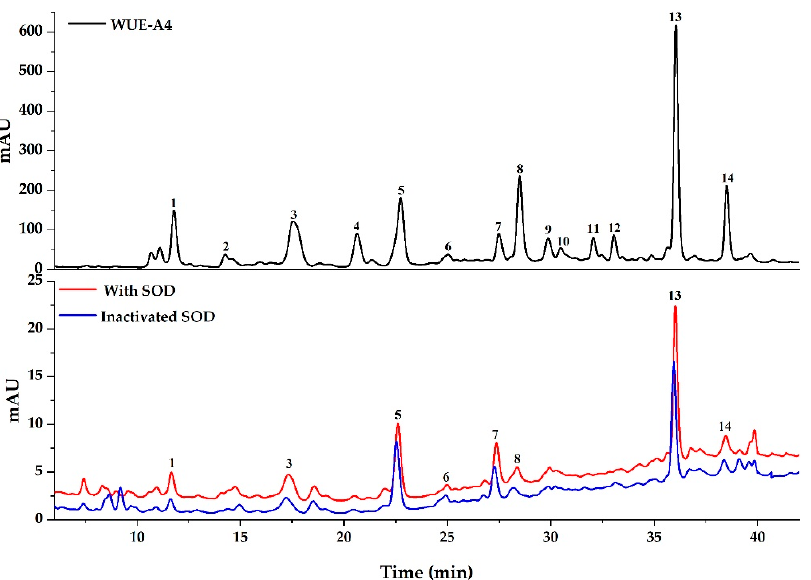
Figure 3. The UF-HPLC-UV chromatograms of WUE-A4 with superoxide dismutase. The black, red, and blue lines represent the HPLC-UV profiles of WUE-A4 without ultrafiltration, with activated and inactivated superoxide dismutase, respectively.